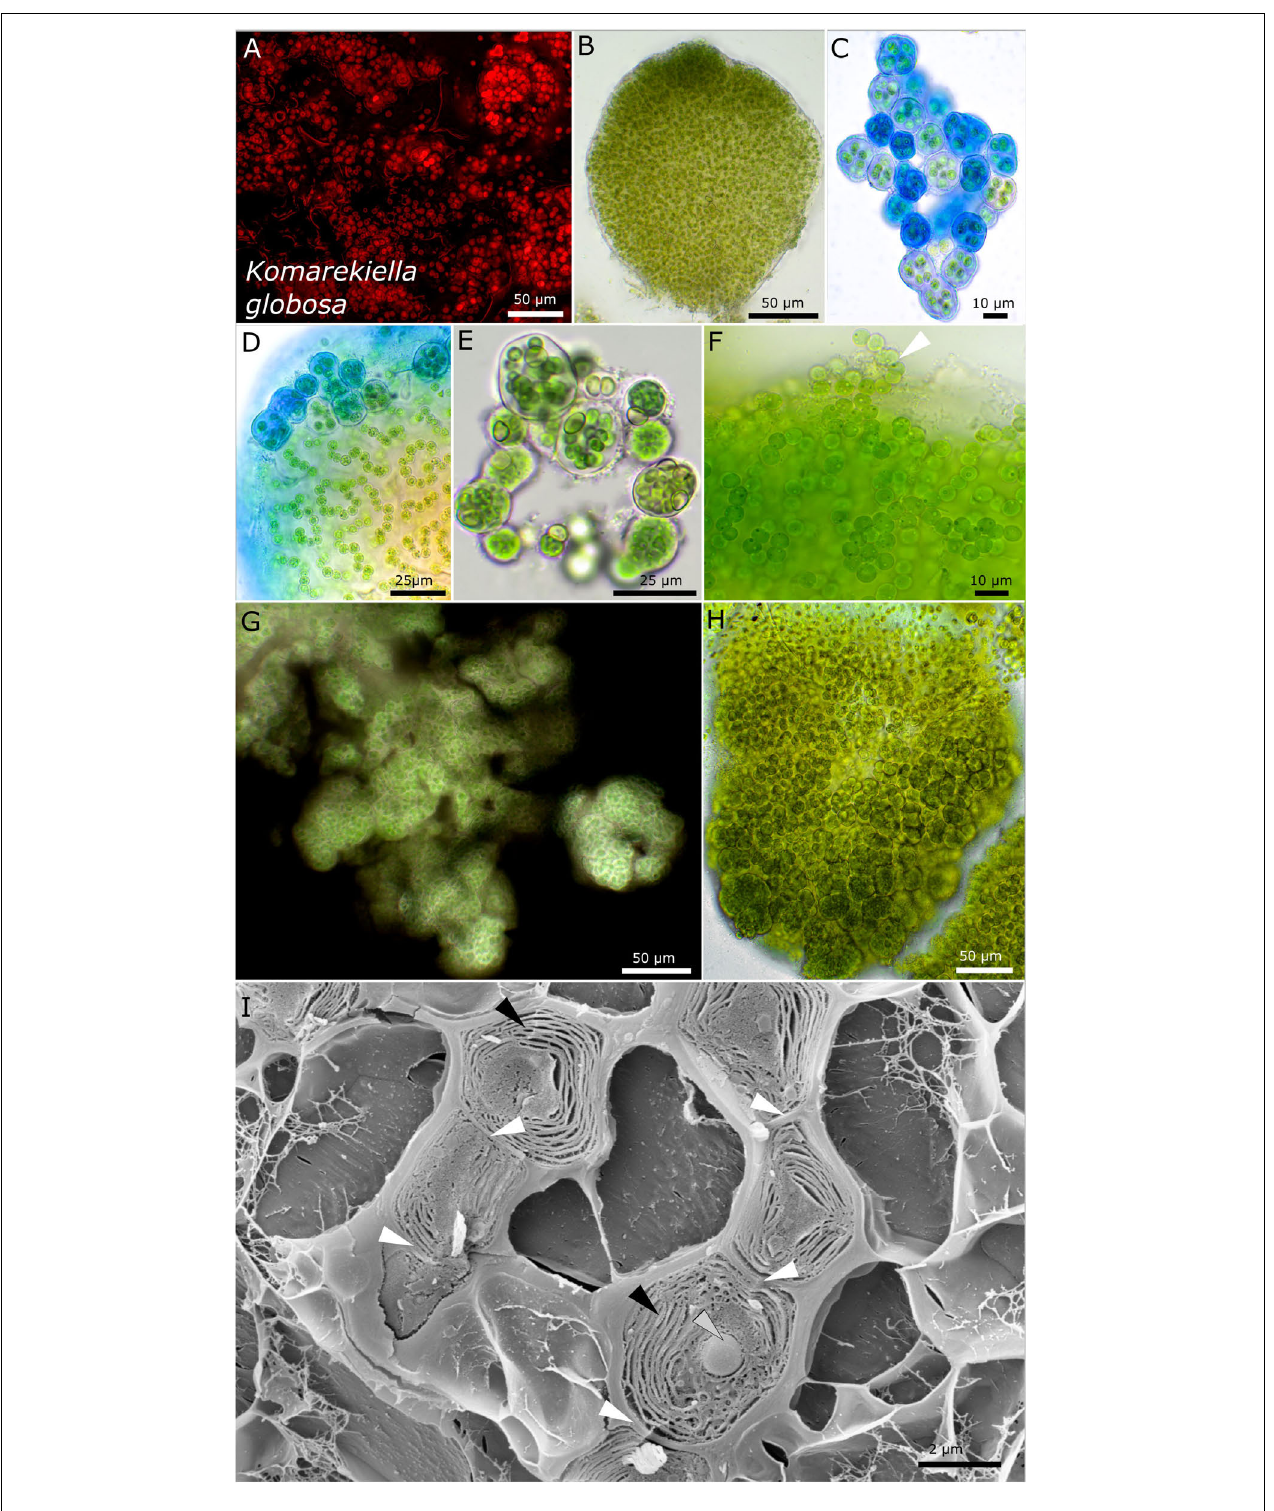
FIGURE 7 | Micrographs of Komarekiella globosa . (A) Autofluorescence, (B–H) light microscopy, and (I) low-temperature scanning electron microscopy (SEM). (B) Cross-section through a globose, macroscopic colony. (C) ACN staining of young colonies showing the limited, hyaline sheath stained in blue. (D) Detail of macroscopic, globose colony stained with ACN showing the release of young, rounded colonies from the periphery of the big colony that contains cell filaments and an extensive extracellular polymeric matrix. (E) Praemordia with heterocytes under nitrogen-depleted conditions with small cells that are compressed. (F) Release